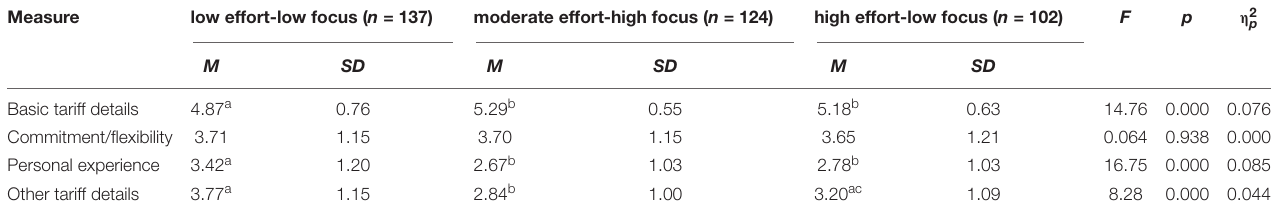
TABLE 5 | Means, Standard Deviations and Results of the MANOVA on the Subjective Relevance of Contract Characteristics. Measure low effort-low focus ( n = 137) moderate effort-high focus ( n = 124) high effort-low focus ( n = 102) F η 2 p